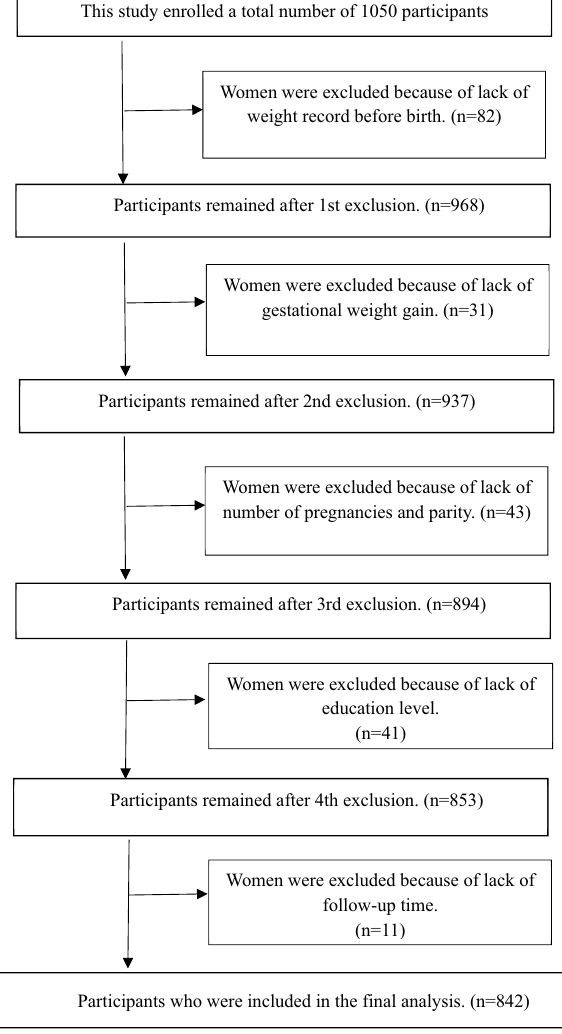
Figure 1: Process about inclusion and exclusion of